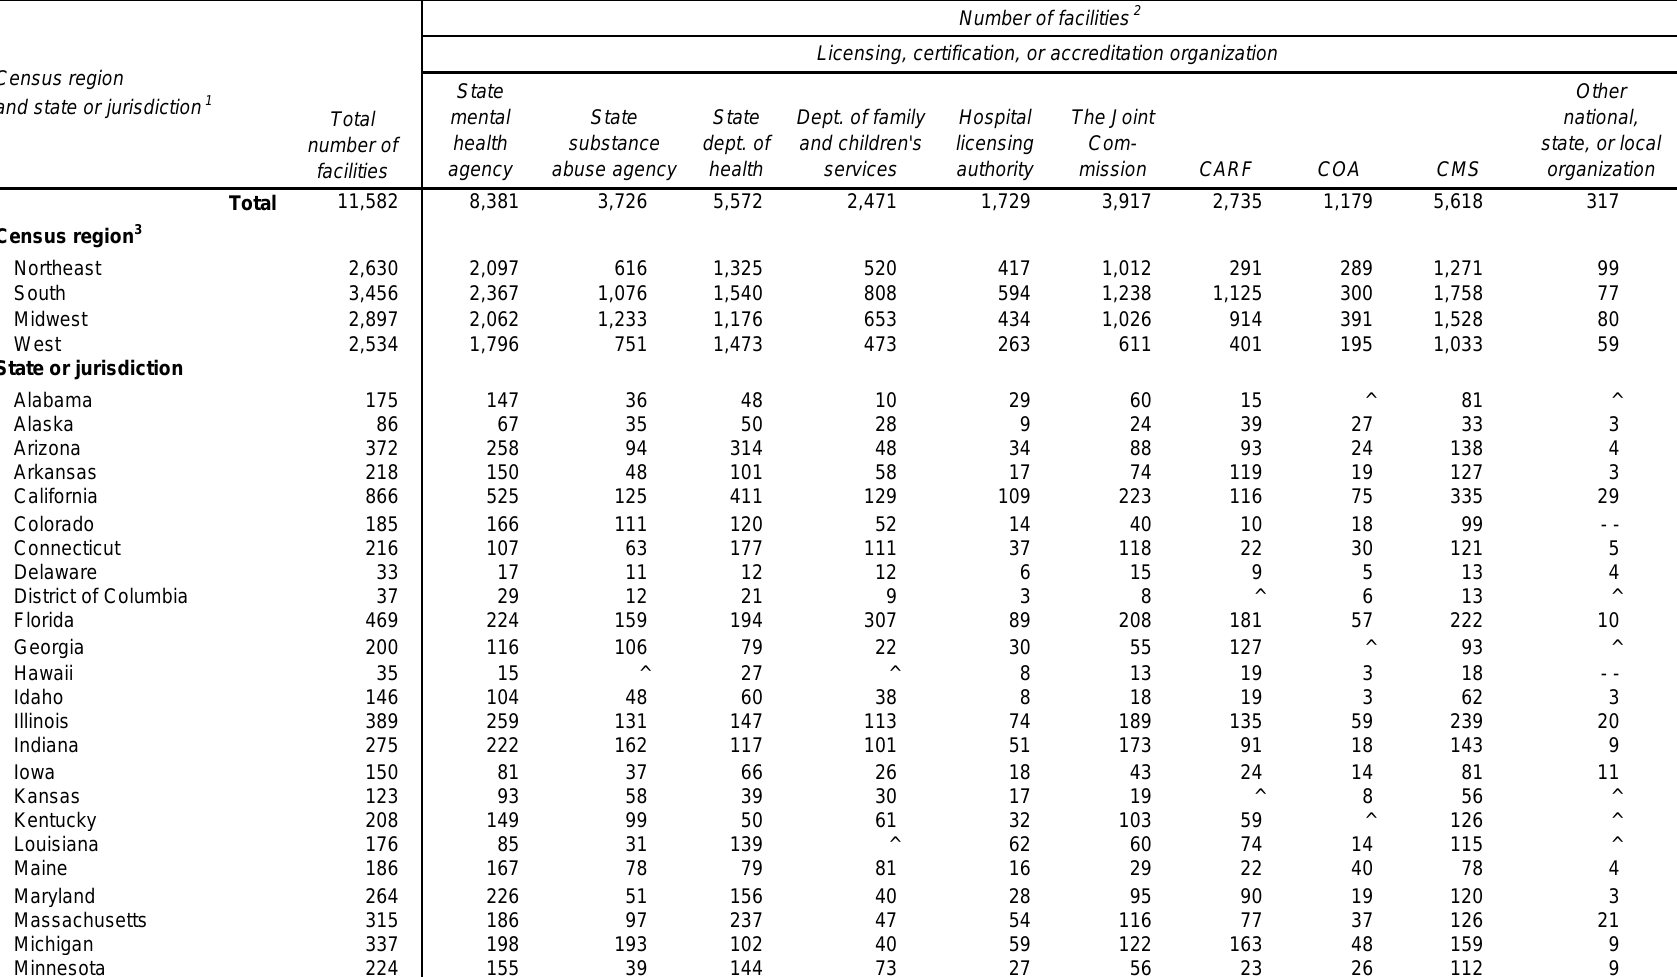
Table 3.14a. Mental health treatment facility licensing, certification, or accreditation, by Census region and state or